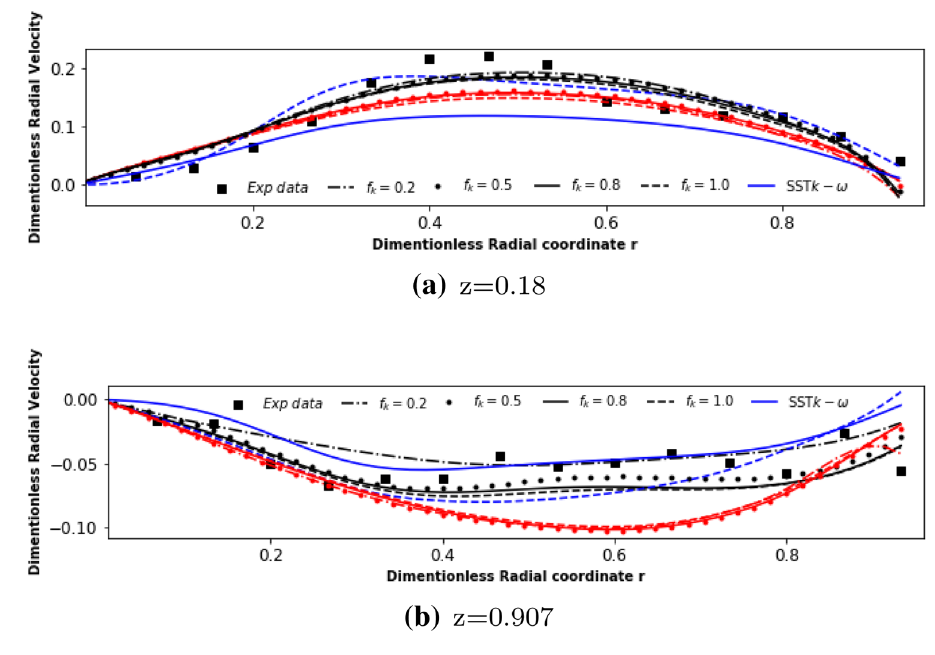
Fig. 4 Comparison between upwind and power-law scheme for PANS k u − 𝜖 u and SST k − 𝜔 model. PANS k u − 𝜖